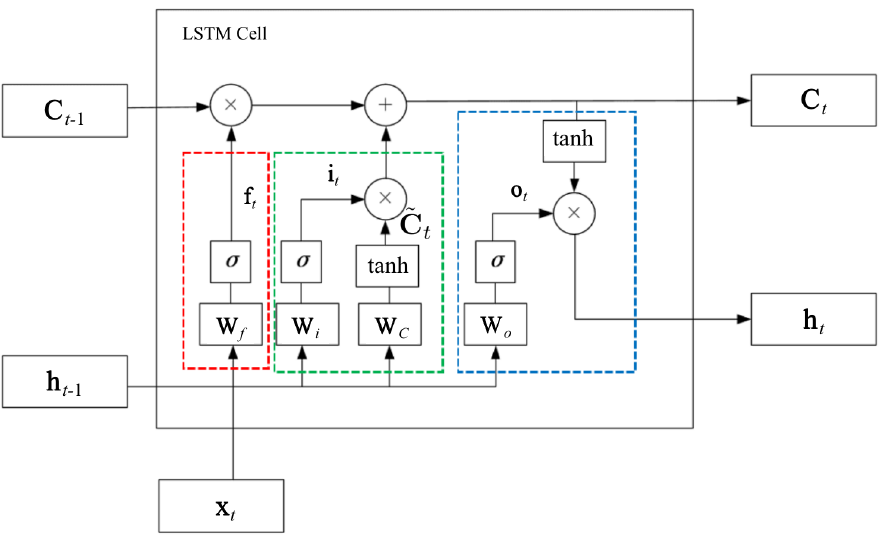
Figure 1. Structure diagram of LSTM